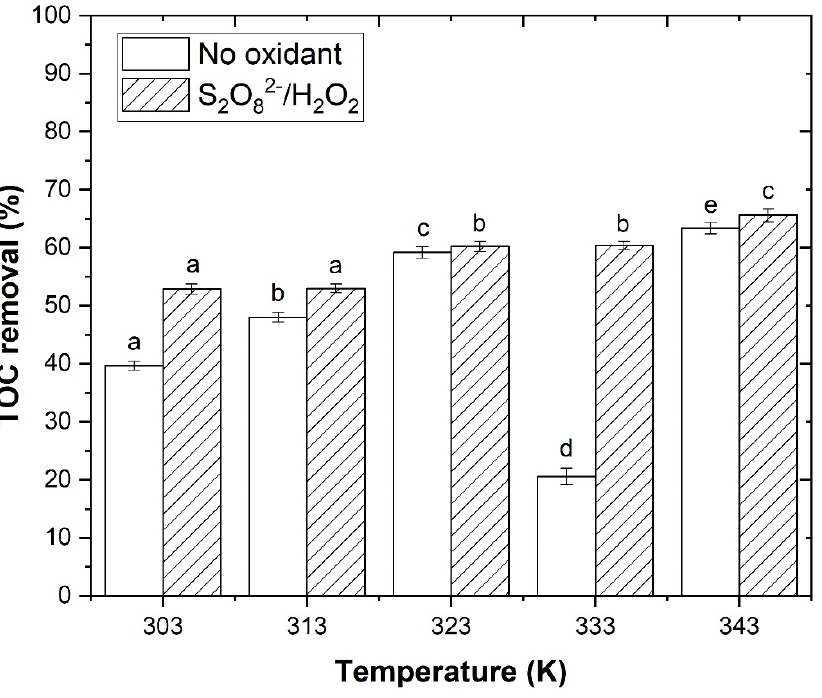
Figure 8. Evolution of TOC removal at different temperatures (303–343 K) in thermocatalytic oxidation, under the following operational conditions: S 2 O 82 - /H 2 O 2 ratio = 1:0.25, S 2 O 82 - /H 2 O 2 dosage = 0.1:0.025 ( g/g ), pH = 7.0, agitation 350 rpm, t = 2 h. Blank experiments at different temperatures (303–343 K) are also shown as reference, under the following operational conditions: pH = 7.0, agitation 350 rpm, t = 2 h. Means in bars with different letters represent significant differences ( p < 0.05) between each process (Blank and thermocatalytic oxidation) by comparing temperatures.